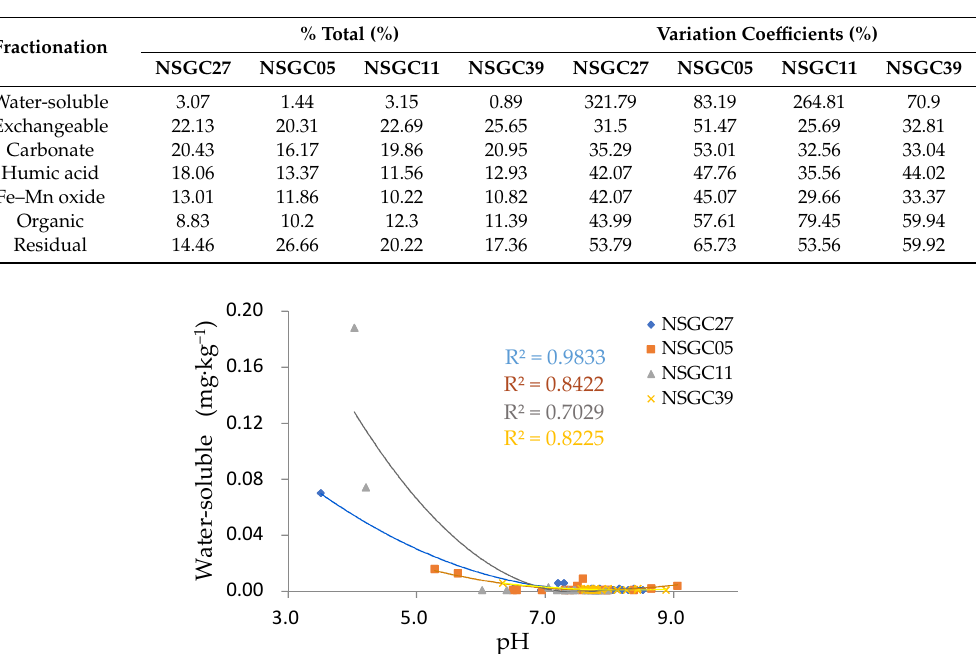
Table 7. % Total and variation coe ffi cients for Cd fractionation in each core.